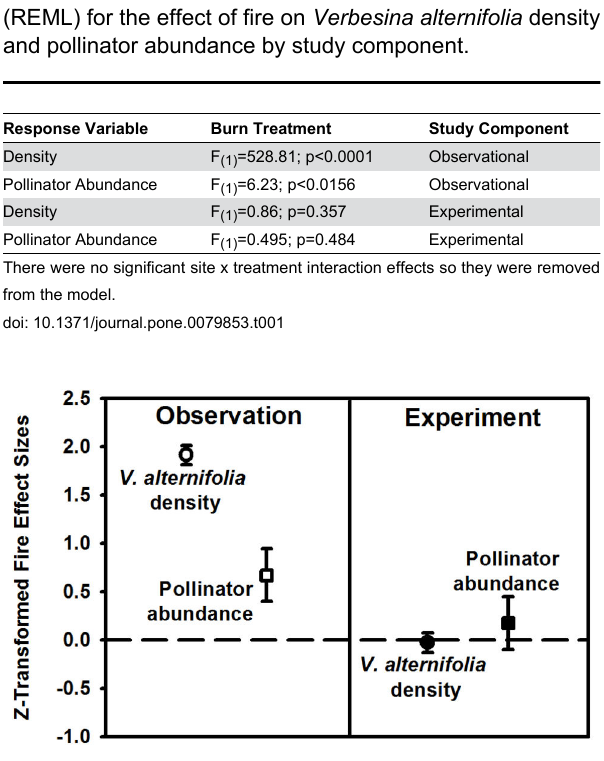
treatments shows no effect of fire on pollinator abundance. greater than zero indicate a positive effect of fire. Error bars show ± 1 SE and, when non-overlapping with zero, indicate significant differences.